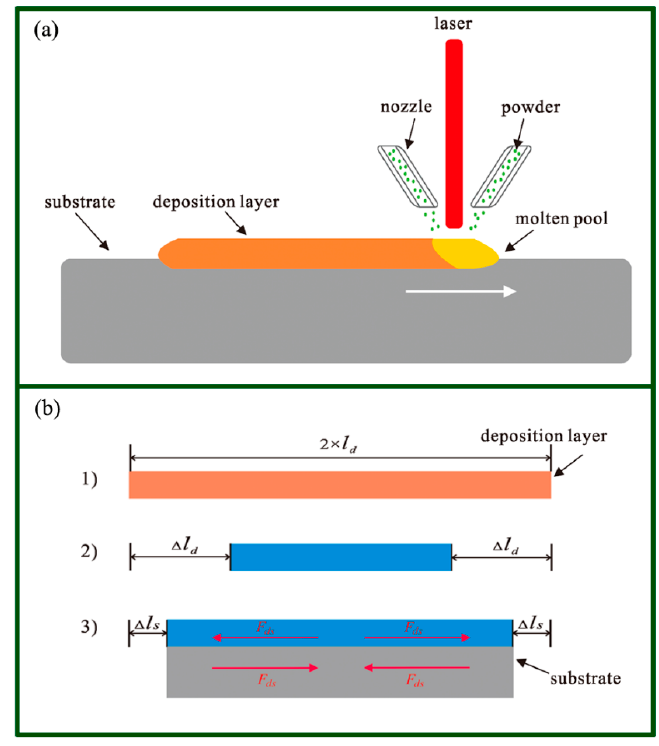
Figure 1. Assumption of the constraining force between a deposited layer and the substrate. ( a ) A schematic illustrating of laser melting deposition. ( b ) The assumption of constraining force F ds : (1) The length of deposited track at high temperature is 2 × l d . (2) The shrinkage of the deposited track at low temperature is 2 × Δ l d if there is no constraint. (3) The shrinkage of deposited track at low temperature was 2 × Δ l s if it is constrained by the substrate. From the view of elastic mechanics, the deposited track is stretched by forces from the substrate. The force caused by the constraint of the substrate was assumed to be F ds .